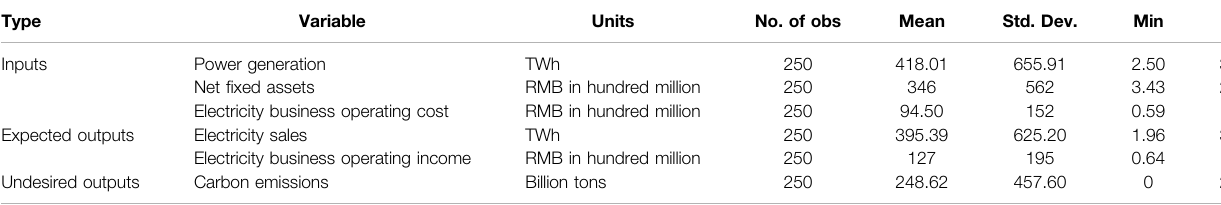
TABLE 2 | Description statistics of the variables. Type Inputs